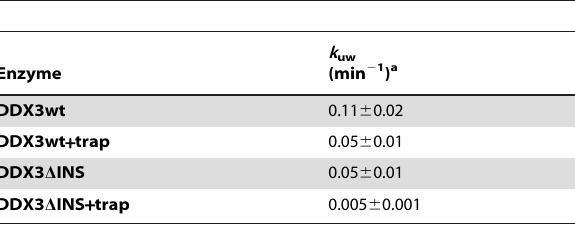
Table 3. Kinetics of RNA unwinding by DDX3wt and the DDX3 D INS